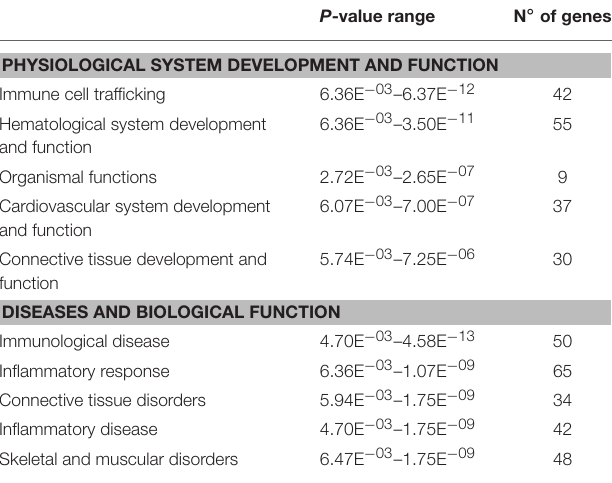
TABLE 4 | Biological functions, physiological processes, and diseases that were over-represented by genes that were differentially expressed in HF-LEX group compared to HF-SED